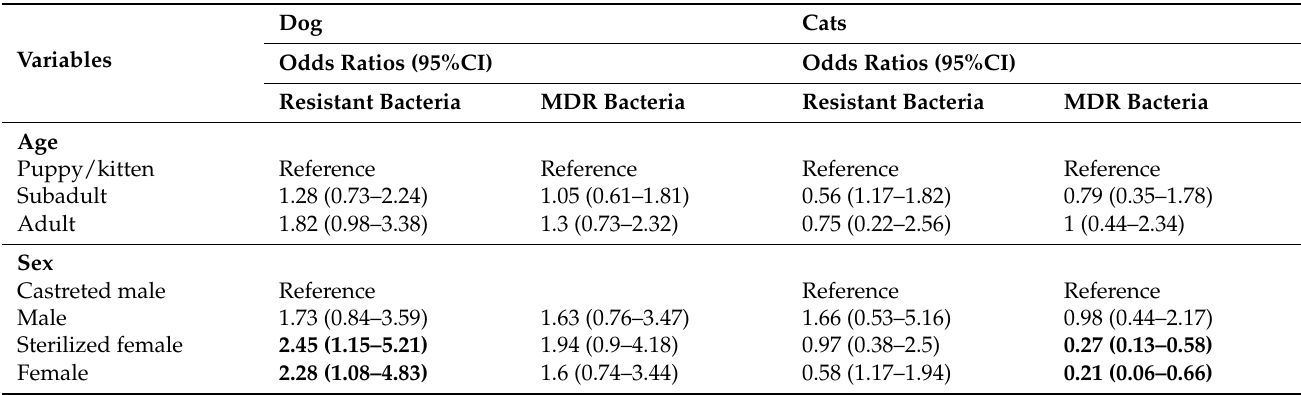
Table 3. Univariable logistic regression analysis for variables associated with resistant and multidrug-resistant bacteria isolated from urine samples of dogs and cats in Central Italy